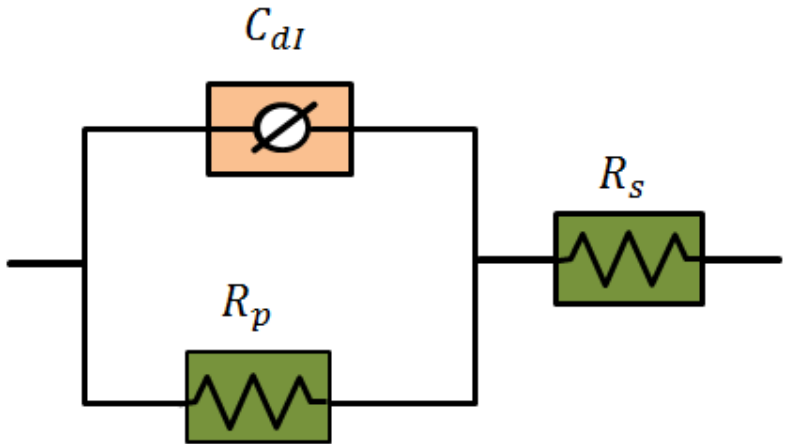
Table 2. Electrochemical impedance spectroscopy parameters.